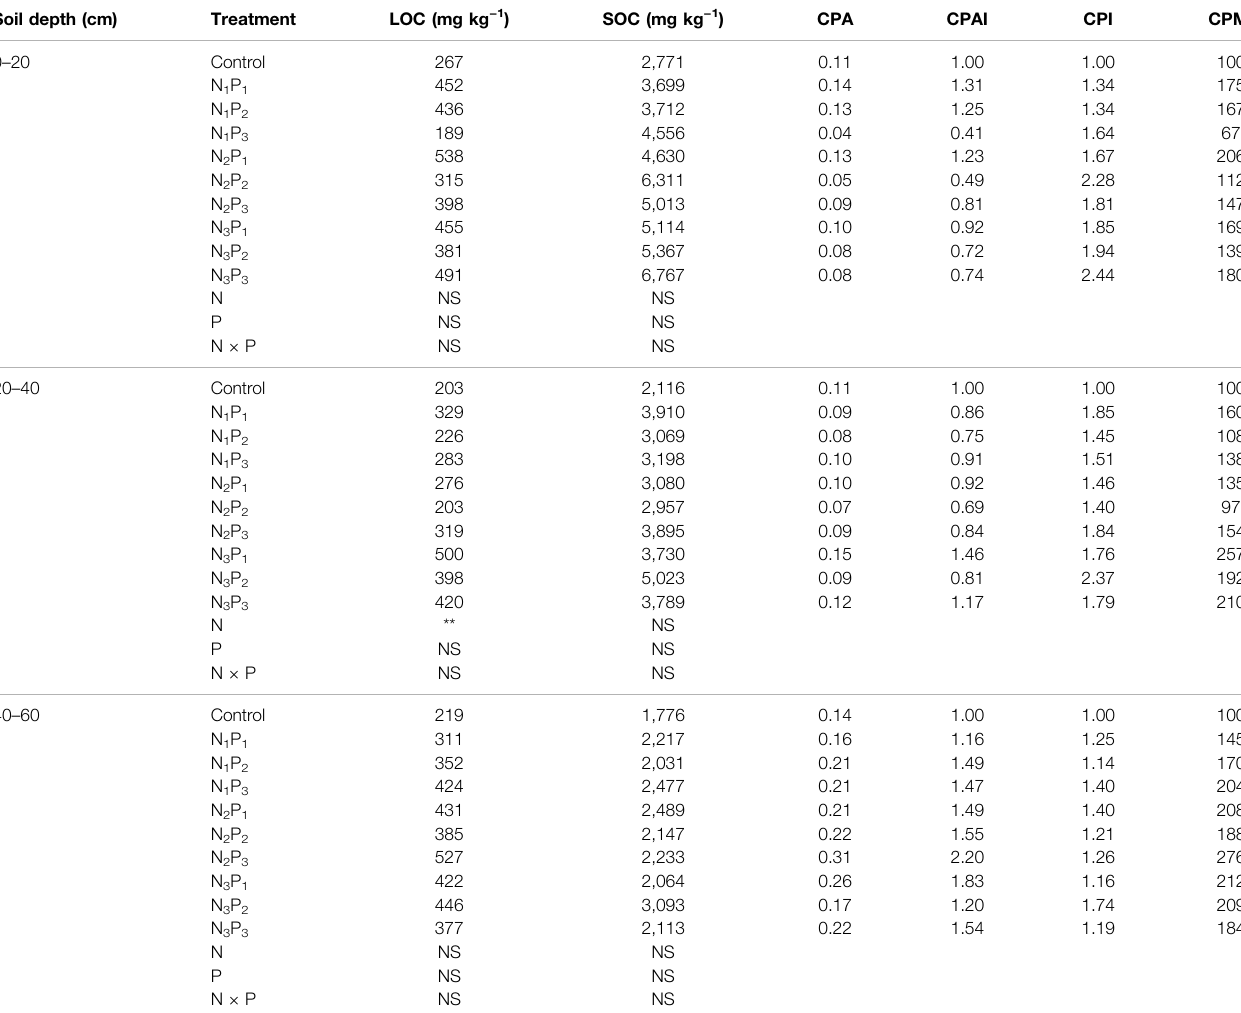
TABLE 3 | Carbon pool management index (CPMI) under different fertigation treatments. Soil depth